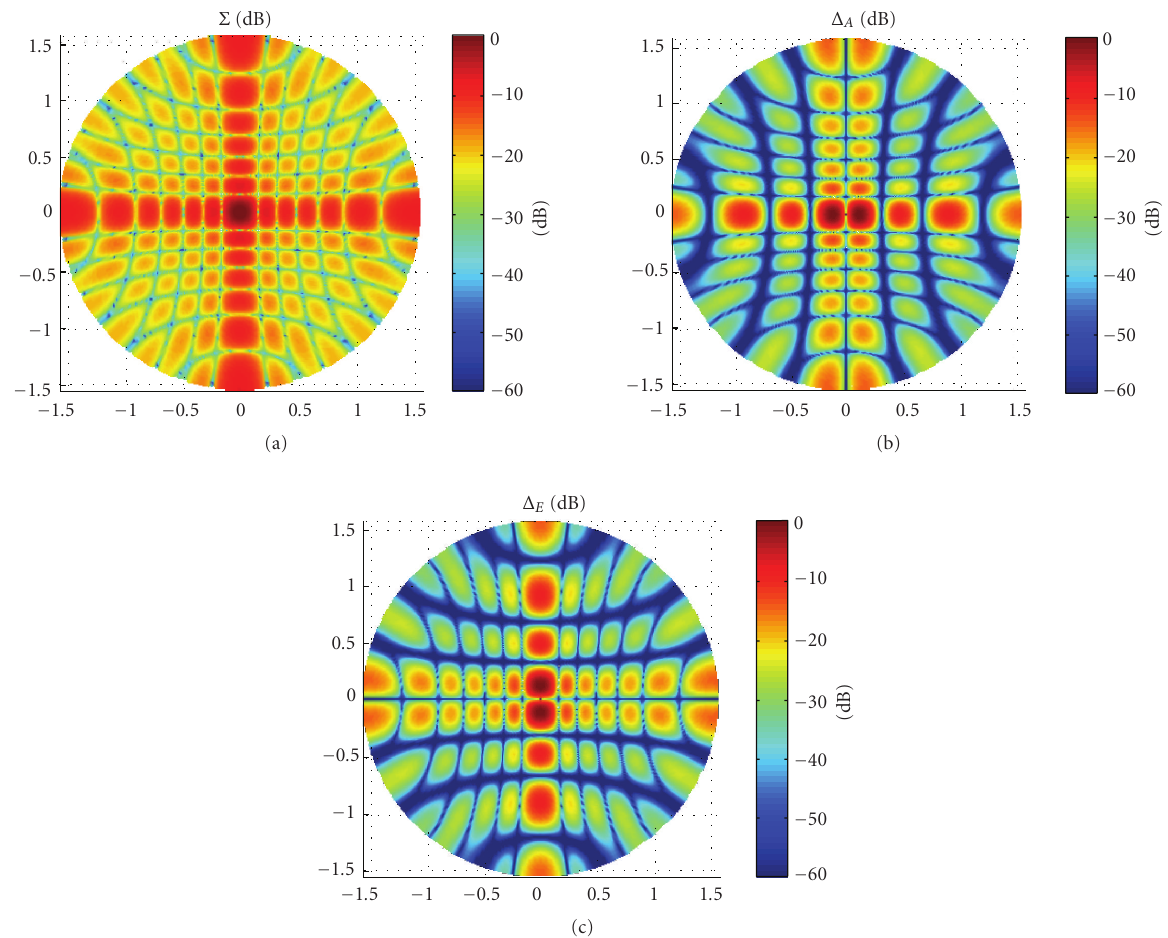
Figure 5: Patterns for a standard monopulse. Patterns are given in a polar reference where the spherical angles ( θ , φ ) are mapped onto ( ρ , φ ) coordinates. It is very evident the vertical line of nulls in the azimuthal di ff erence pattern and the horizontal line of nulls in the elevation di ff erence